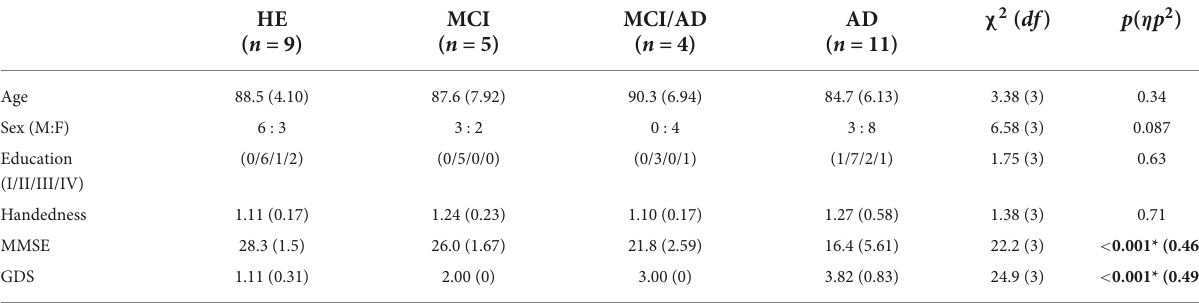
TABLE 4 Sample characteristics of the longitudinal study with four groups of elderly participants, incorporating a group whose initial diagnosis of MCI was changed to AD at the 2nd moment of assessment (MCI/AD